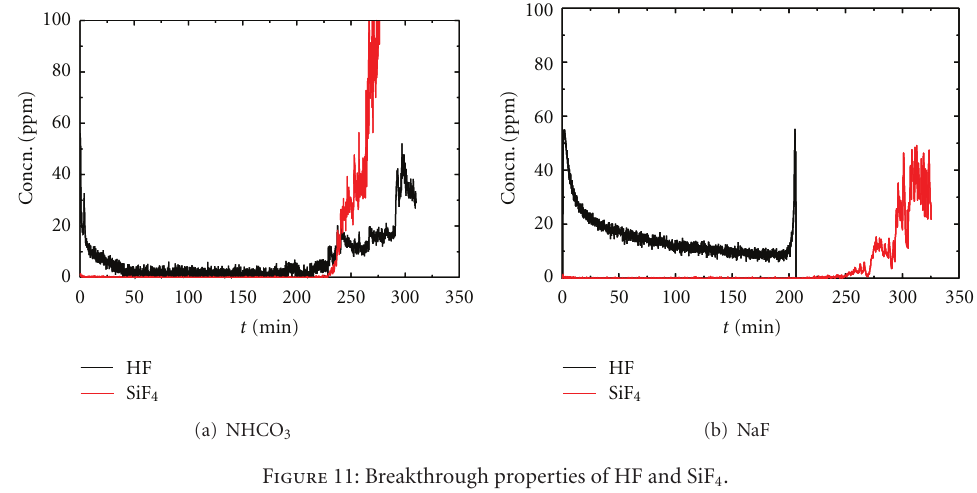
Figure 11: Breakthrough properties of HF and SiF 4 .